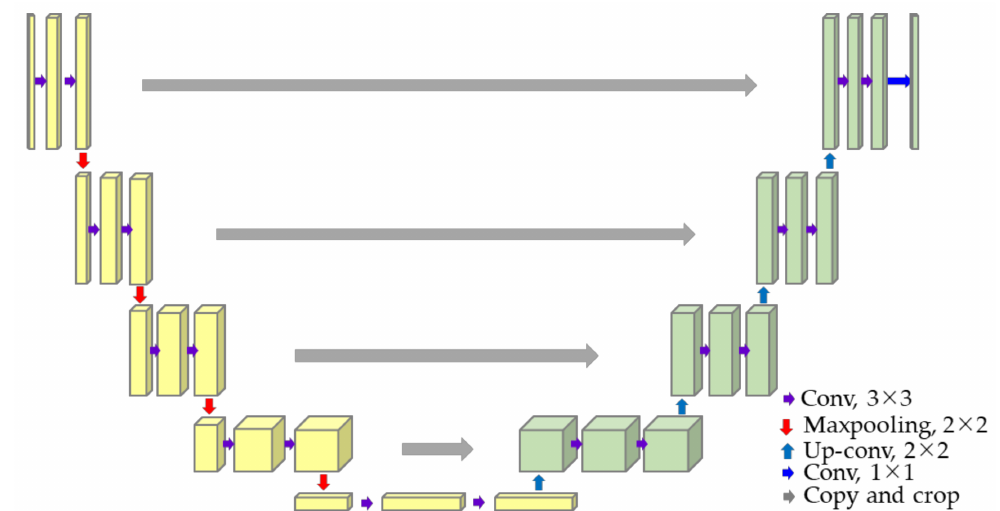
Figure 13. The structure of the U-Net model applied in this